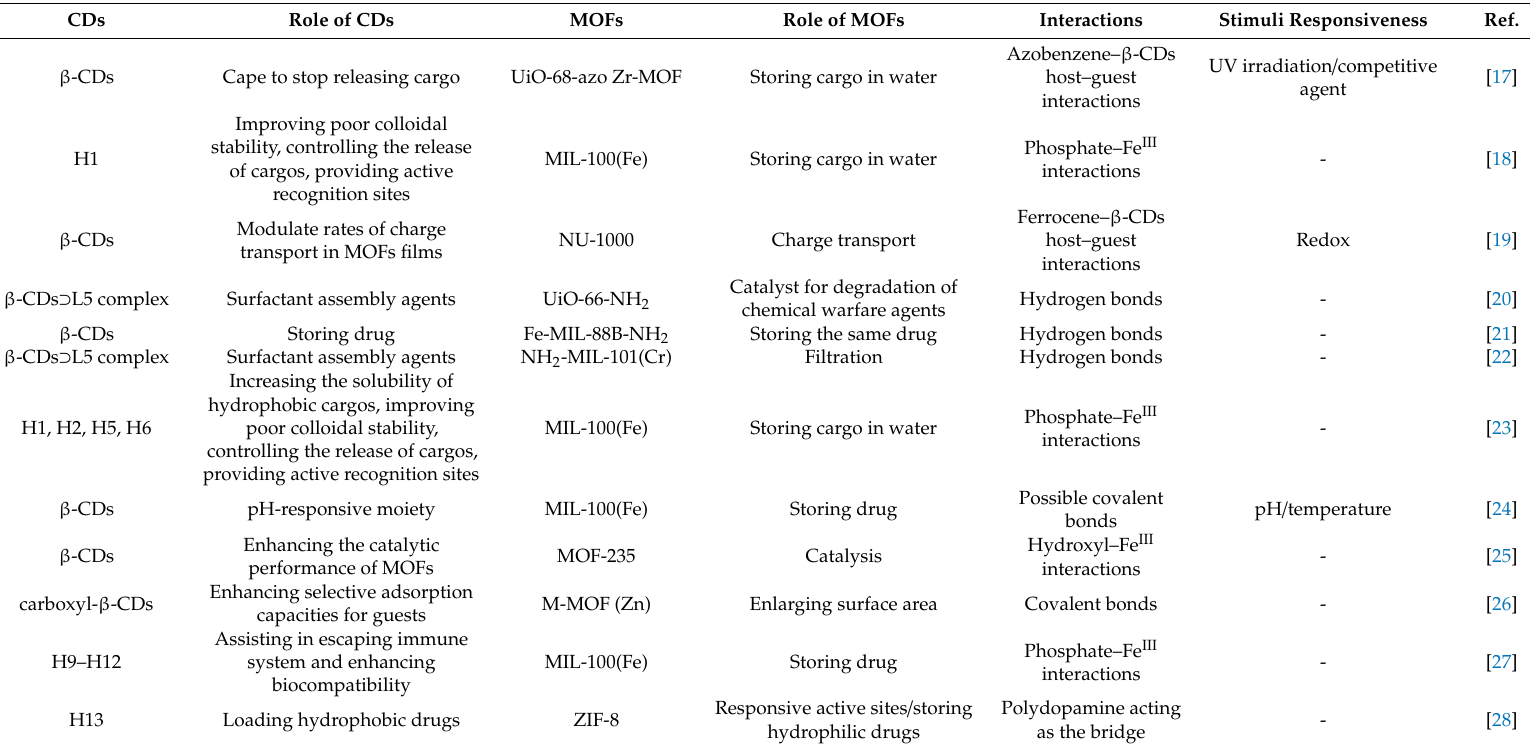
Table 1. The various compositions of CDs-modified / coated MOFs indicating di ff erent roles of CDs and MOFs, the supramolecular interactions and covalent bonds between them, as well as possible external stimuli responsiveness to control the organic–inorganic hybrid materials for future